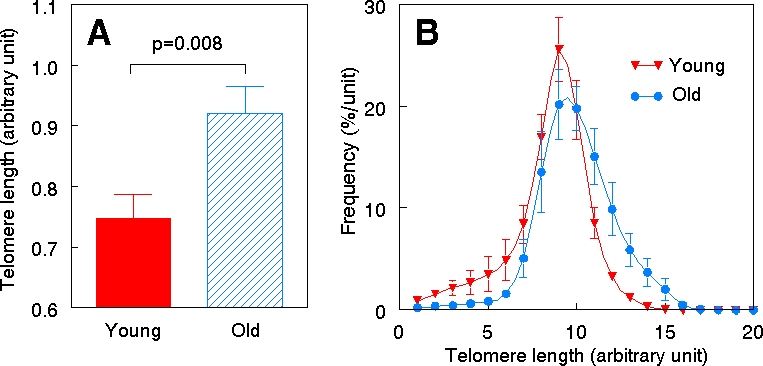
Telomere Lengths by Flow-FISH in Sperm from Young and Older Donors(A) Mean telomere length (in relative units) based on signal telomere intensity.(B) Composite of frequency distributions of signal intensity.Each bin represents 35 output signals. The connecting lines are spline estimations.